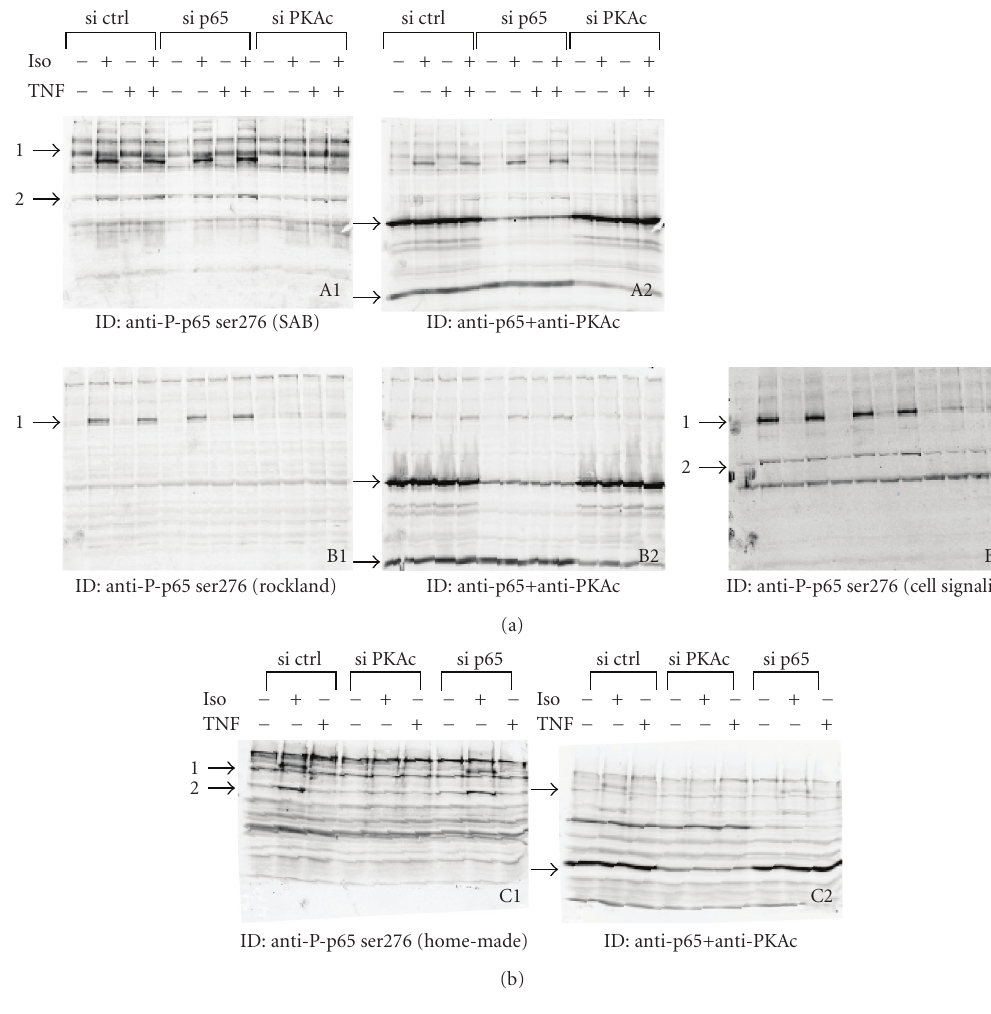
Figure 3: Four independent anti-P-p65 Ser276 antibodies detect inducible bands, with MWs of 80 and 130 kDa, that do not disappear upon p65 knock-down, but are inhibited when PKAc α is silenced. 1321N1 cells were transiently transfected with control, p65 or PKAc α siRNA, as described in Section 2. Cells were induced for 90 min with TNF- α (2000IU/mL), iso (10 μ M) or a combination of both stimuli. Presence of Ser276-phosphorylated p65 in cell lysates was analysed by Western Blot using SAB no. 11011 (A1), Rockland no. 100-401-264 (B1), Cell Signaling no. 3037 (B3), or a homemade anti-P-p65 Ser276 antibody (C1). 130 and 80 kDa immunoreactivities are indicated by arrows (1 and 2, resp.). Blots were extensively washed and reprobed with a mixture of anti-p65 and anti-PKAc α to investigate knock-down e ffi ciency. Anti-p65-detected bands are marked by the upper arrow, anti-PKAc α -reactive bands are marked by the lower arrow (A2, B2, C2). Tubulin loading controls are added as Supplementary Figure